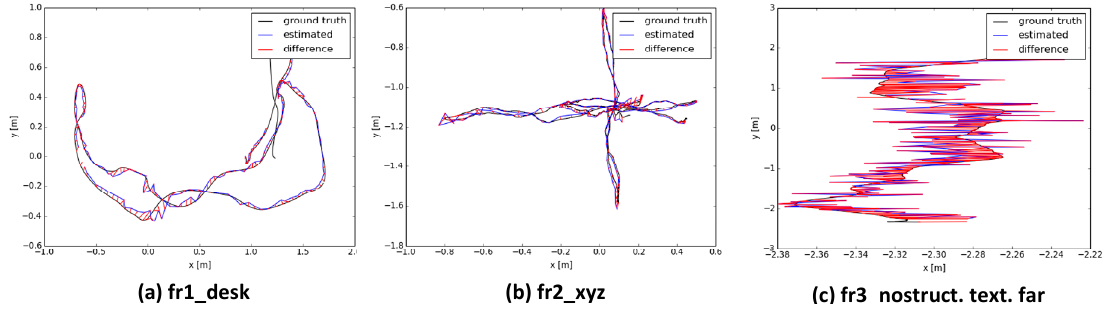
Figure 6. Estimated trajectories compared against ground truth trajectories.